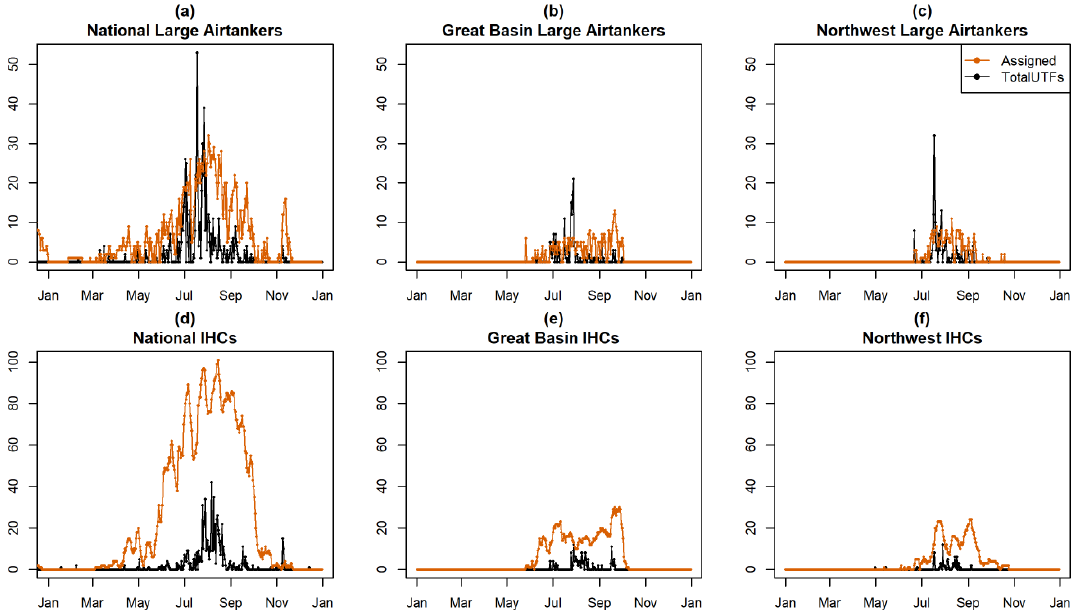
Figure 6. Three subsets of data (one subset per column) showing the two daily metrics of resource use and scarcity for large airtankers (top row of each set) and IHCs (bottom row of each set) from all 2018 ROSS requests. The orange line indicates the number of such resources assigned each day as recorded in ROSS. The black line indicates the number of requests returned Unable to Fill (UTF) as recorded in ROSS. The left two graphs are all requests within the US. The middle two graphs are all requests from the Great Basin Geographic Area. The right two graphs are all requests from the Northwest Geographic Area.